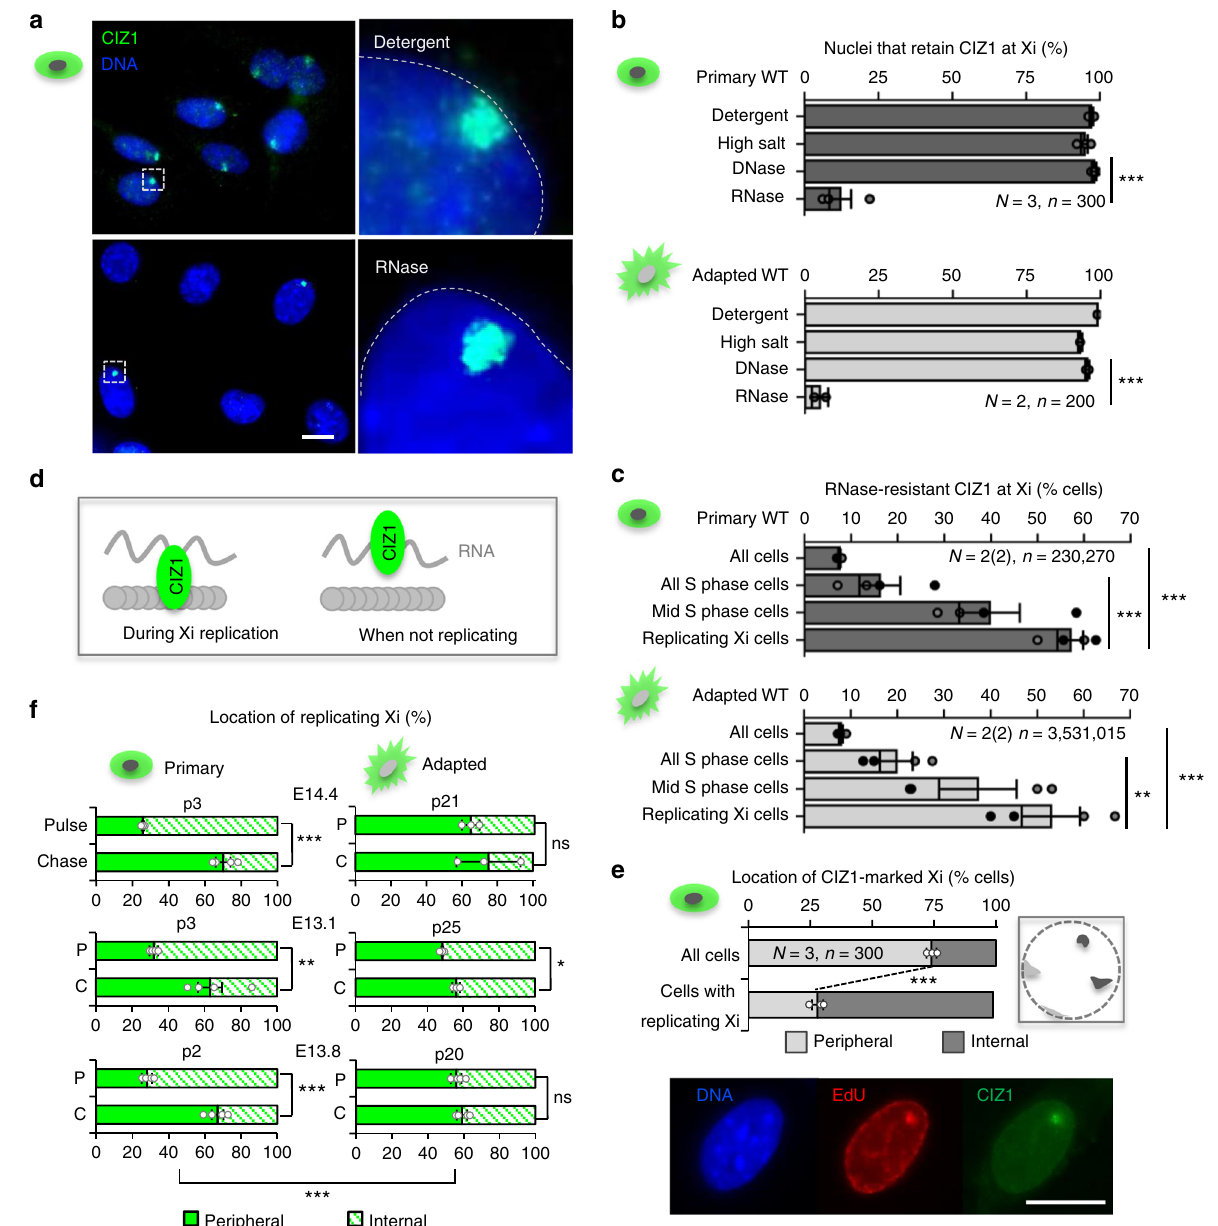
Fig. 1 Xi location during S phase. a CIZ1 at Xi in cycling WT primary embryonic fi broblasts (PEFs), with and without extraction of RNA and associated proteins, detected with anti-CIZ1 antibody 1794 (green). DNA is blue, scale bar 10 microns. b Proportion of cells that retain CIZ1 at Xi (Xi-CIZ1) at the indicated steps after extraction, for three independent populations of WT PEFs (means ± SEM for 13.1, 13.8, 14.4 at passage 3 – 4, n > 100 for each step and each line. Signi fi cant differences are indicated ( t -test). Similar results for culture-adapted derivative line 13.1 (passage > 20), and 3T3 cells is shown below, ±SDEV. c Proportion of cells with RNase-resistant Xi-CIZ1 after pulse-labelling with EdU to classify cells by S-phase stage (Supplementary Fig. 1). Upper graph shows mean data for WT primary cells 13.1 and 13.8 (passage 3 – 4), each in duplicate, ±SEM ( t -test). Lower graph shows the same analysis for WT MEFs (13.1, passage> 20), and 3T3 cells, each in duplicate. d Illustration of transient attachment of Xi-CIZ1 (green) to non-chromatin, non-RNA assemblies (grey circles) during Xi replication. e Location of Xi-CIZ1 at the time of Xi replication (detected by 30 min pulse label with EdU) compared to the rest of the cell cycle. Location is classi fi ed as peripheral or internal (illustrated right). Means ± SEM for three WT PEFs (13.1, 13.8, 14.4 p3 – 4) are shown ( n = 100 for each), with signi fi cant changes indicated ( t -test). Images show a cell engaged in replication of Xi (EdU, red), co-stained with anti-CIZ1 1794 (green), DNA is blue, scale bar 10 microns. f Xi location (peripheral or internal) at the time of incorporation of EdU (pulse), or 30 min later (chase), analysed by t -test. Graphs show data ± SEM for three WT primary populations (13.1, 13.8, 14.4 p2 – 3), and three derived MEF lines ( p > 20). EdU-Xi in primary WT cells shifts preferred location during the chase period, but remains unchanged in most adapted lines, compared by ANOVA. For all analyses * P ≤ 0.05, ** P ≤ 0.01, *** P ≤ 0.001. N = independent cell lines, n = total nuclei scored. Individual replicates contributing to each mean are overlaid on bar charts, shaded according to cell line where